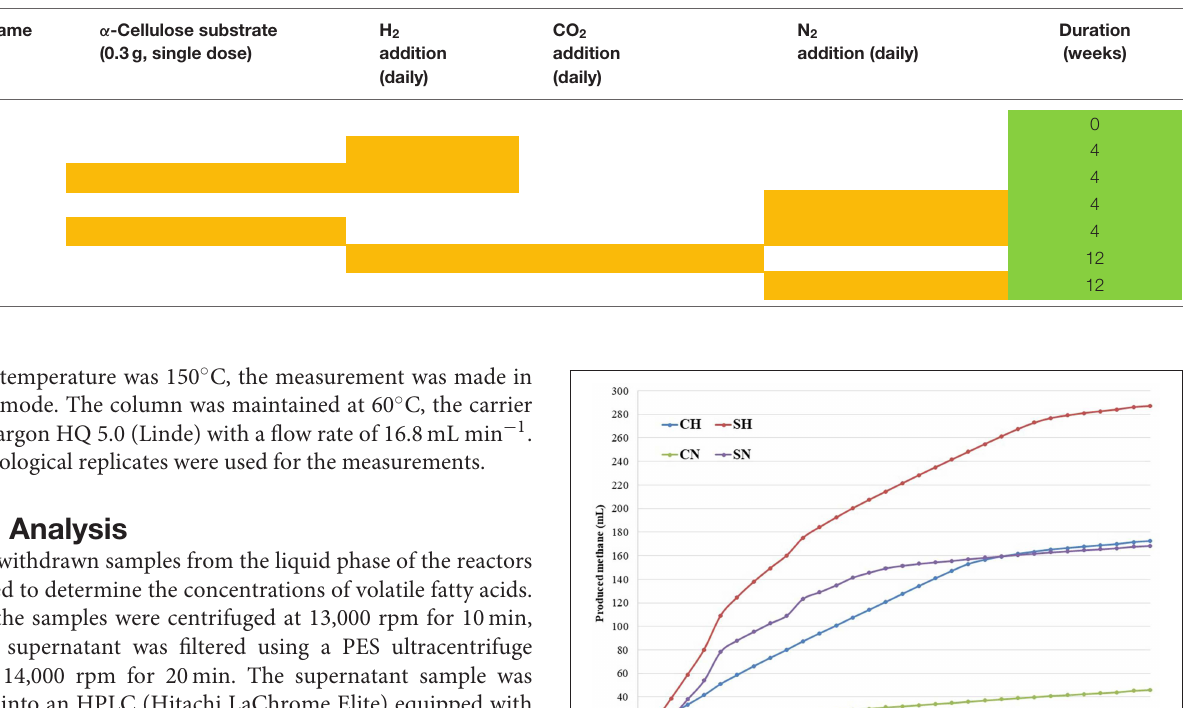
TABLE 1 | Compositions of the reactors (yellow cells) and samples taken for T-RFLP and metagenome sequencing (green cells).